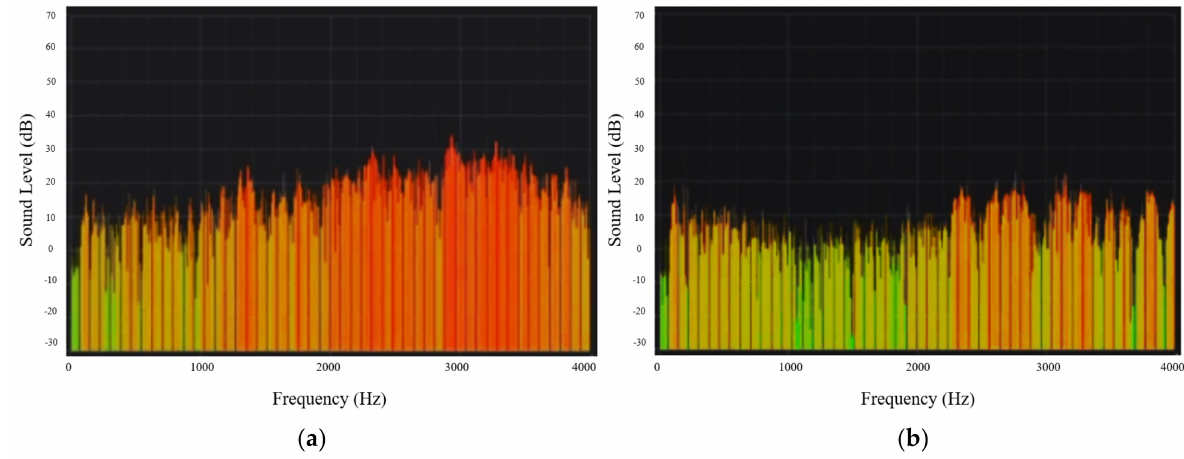
Figure 16. A graph showing sound frequency vs. sound level measured using the case ( a ) without PDMS material and ( b ) with PDMS material.